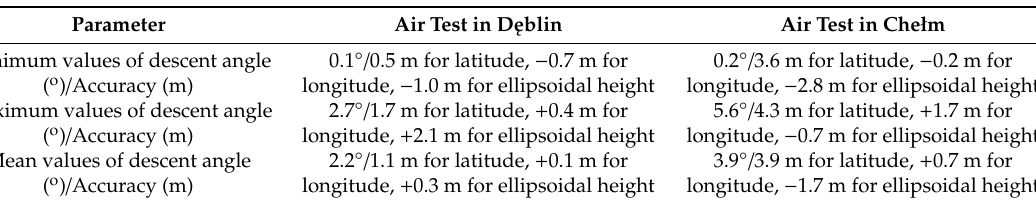
Table 8. The relationship between descent angle and accuracy of aircraft positioning in the air tests in D˛eblin and Chełm.